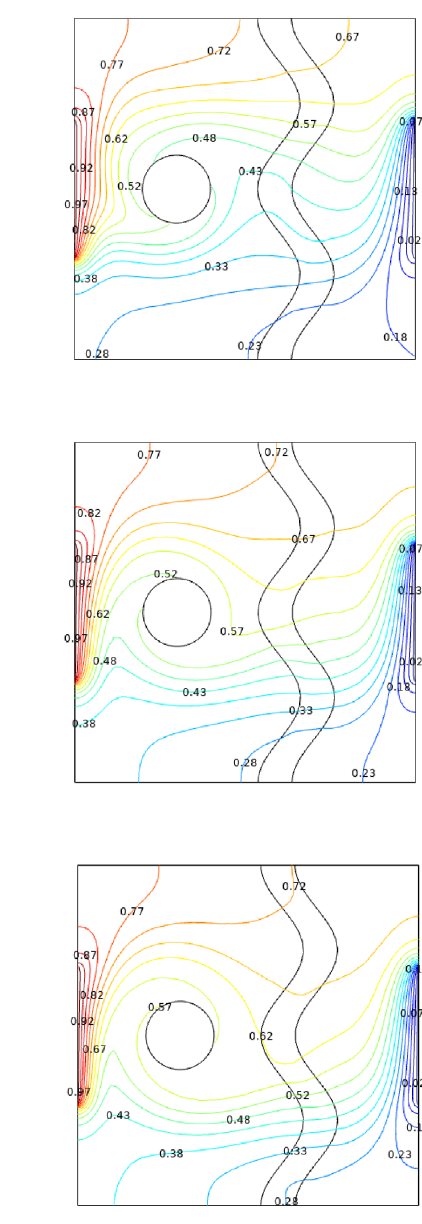
Figure 13. Variations of the streamlines (left), isotherms (right) with various rotational speeds ( ω ) at, 10 5 , Ha 0 , N 0.4 and Da 0.02 , ε 2 , φ Ra = = = = =